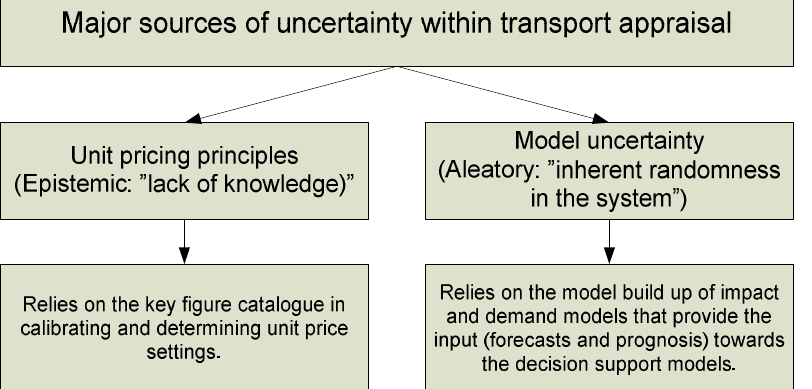
Figure 1. Schematical overview illustrating the two major sources of uncertainty embedded within transport infrastructure assessment (adapted from Vose (2002;